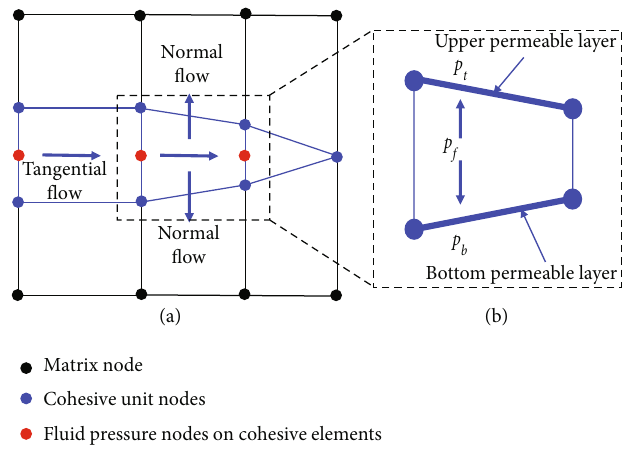
Figure 2: Schematic diagram of element composition of the cohesive zone model. (Figure 1(e)), and matrix fi nite element (Figure 1(d)).